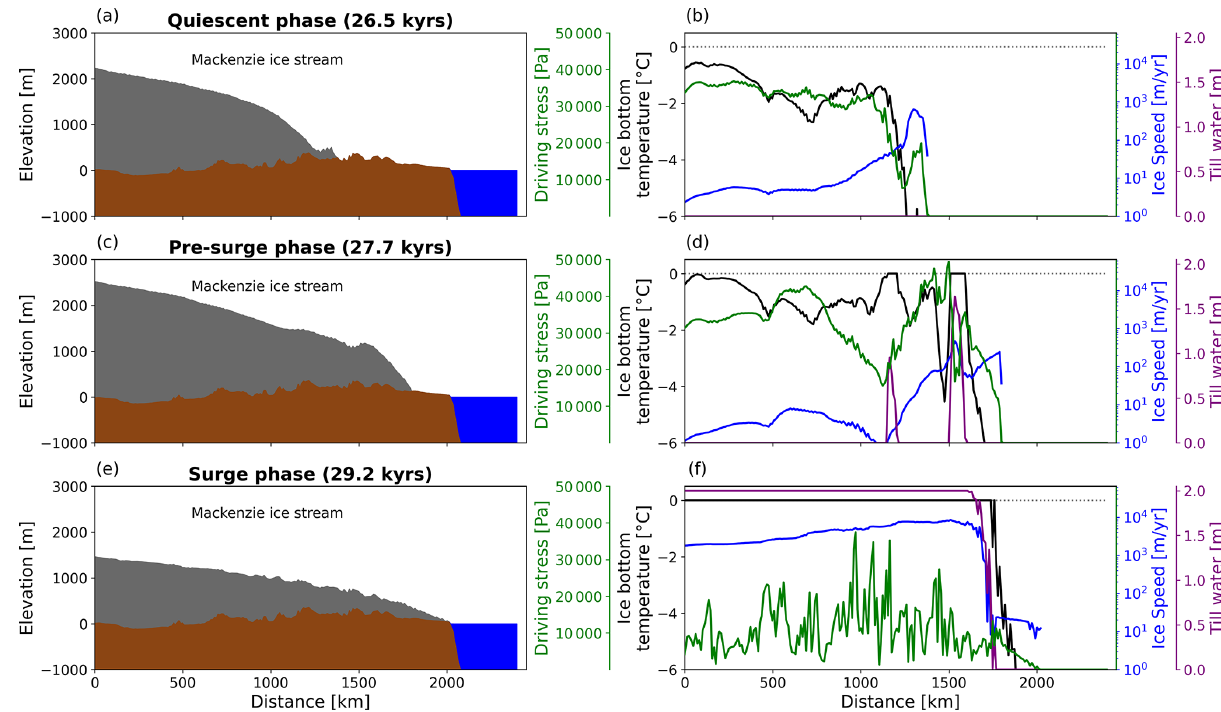
Figure 6. Similar to Fig. 4 but for Mackenzie ice